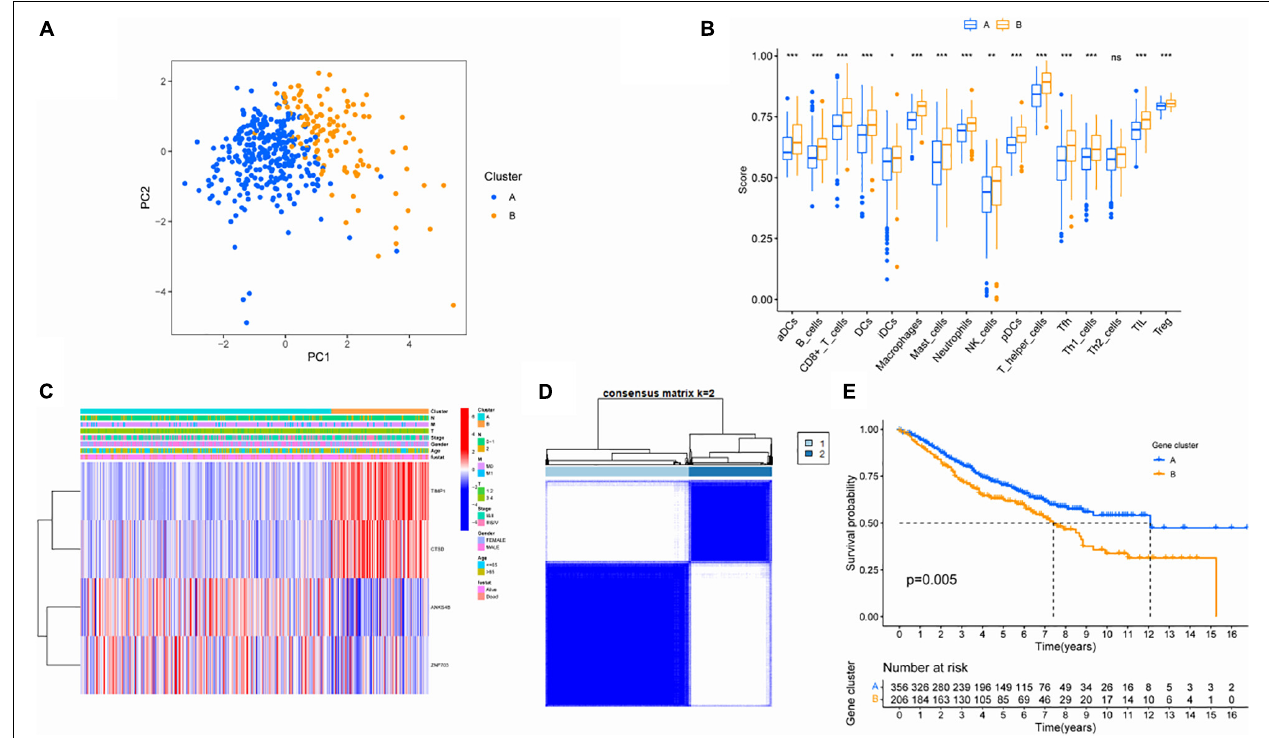
FIGURE 3 | Validation of screened key genes. (A) PCA diagram of the TCGA queue. (B) Comparison of ssGSEA scores among different subgroups. (C) Distribution of hub gene among different subgroups. (D) Consistent clustering analysis based on four hub genes in GSE39582. (E) Survival analysis of patients in different subgroups in the GEO